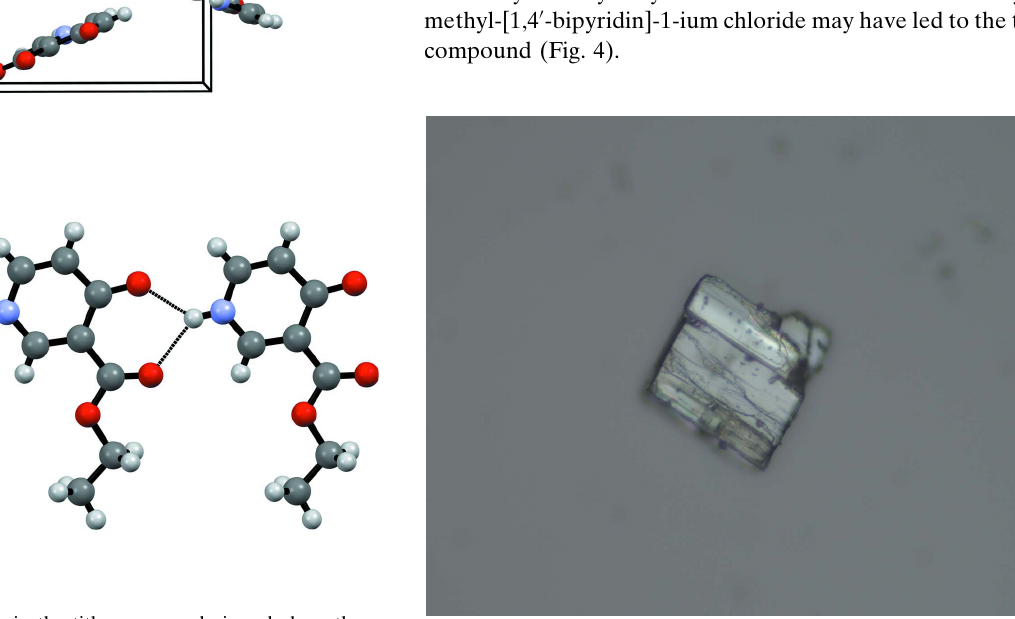
Figure 3 A representative crystal of I.